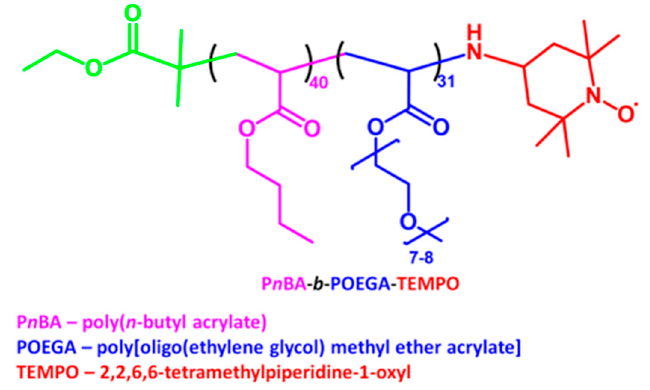
Figure 13. Structure of nitroxide-containing nanoparticles